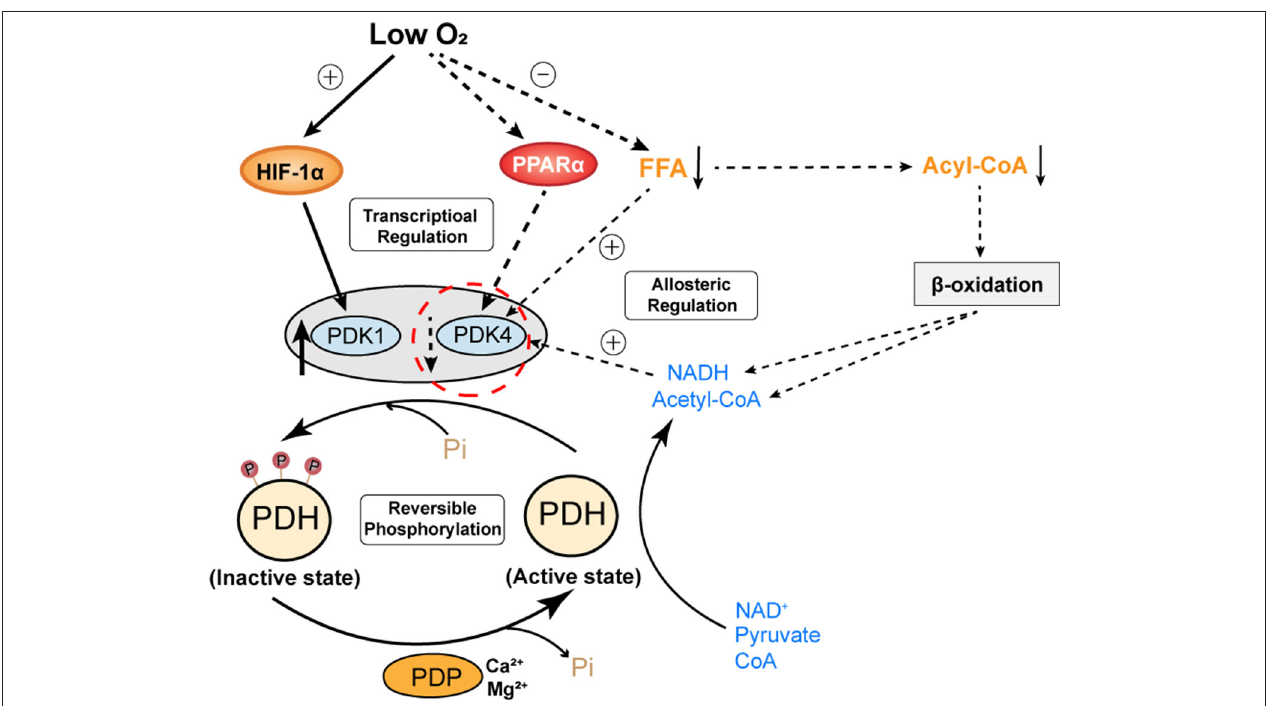
FIGURE 3 | A proposed regulation model of cardiac PDH activity under chronic hypoxia. The activity of PDH is mainly determined by reversible phosphorylation from PDK and PDP. PDK1 is oxygen sensitive and transcriptionally regulated by HIF-1 α . PDK4 is nutrient sensitive, its expression is transcriptionally regulated by PPAR α and its activity is allosterically regulated by FFA and metabolites (NADH, acetyl-CoA) derived from the oxidation of pyruvate or FFA. Under chronic hypoxia, elevated HIF-1 α and decreased PPAR α have opposing effects on the expression of PDK1 and PDK4. However, the activity of PDK4 is also affected by decreased levels of fatty acids and metabolites derived from β -oxidation. Hence, PDK4 appears to be more involved in the regulation of PDH activity in the chronically hypoxic heart. Decreased expression and activity of PDK4 reduce the phosphorylation of PDH, which maintains its active state. PDH, pyruvate dehydrogenase; PDK, pyruvate dehydrogenase kinase; PDP, pyruvate dehydrogenase phosphatase; Pi, inorganic phosphate; FFA, free fatty acids; NADH, nicotinamide adenine